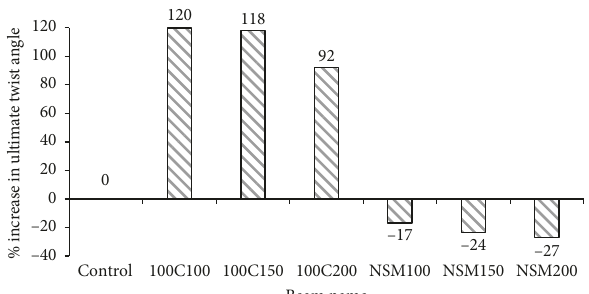
Figure 12: Enhancement percentage of the ultimate twist angle carrying capacity.